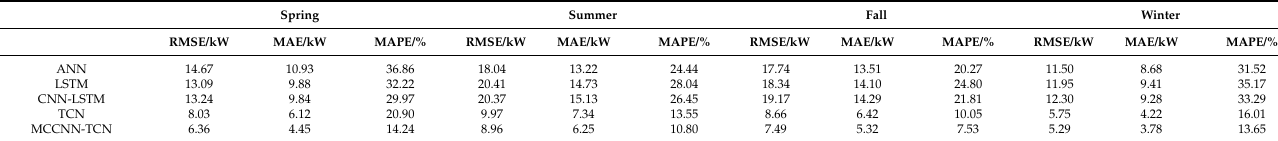
Table 13. Comparison of forecasting errors of models in each season.